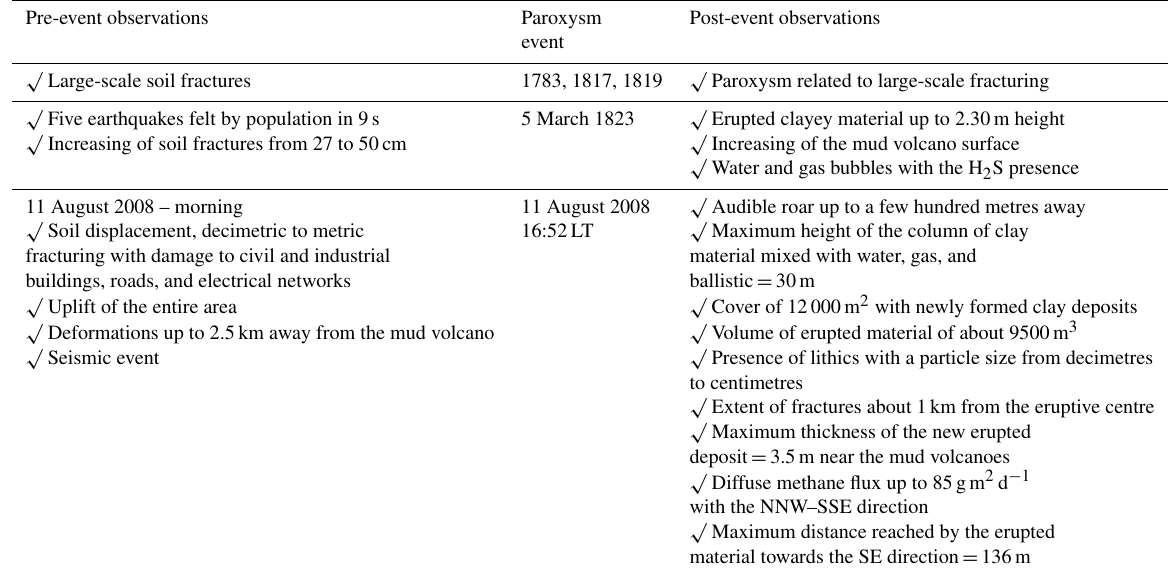
Table 1. Pre-historical and post-historical observations of the historical paroxysm events at Santa Barbara. Pre-event observations